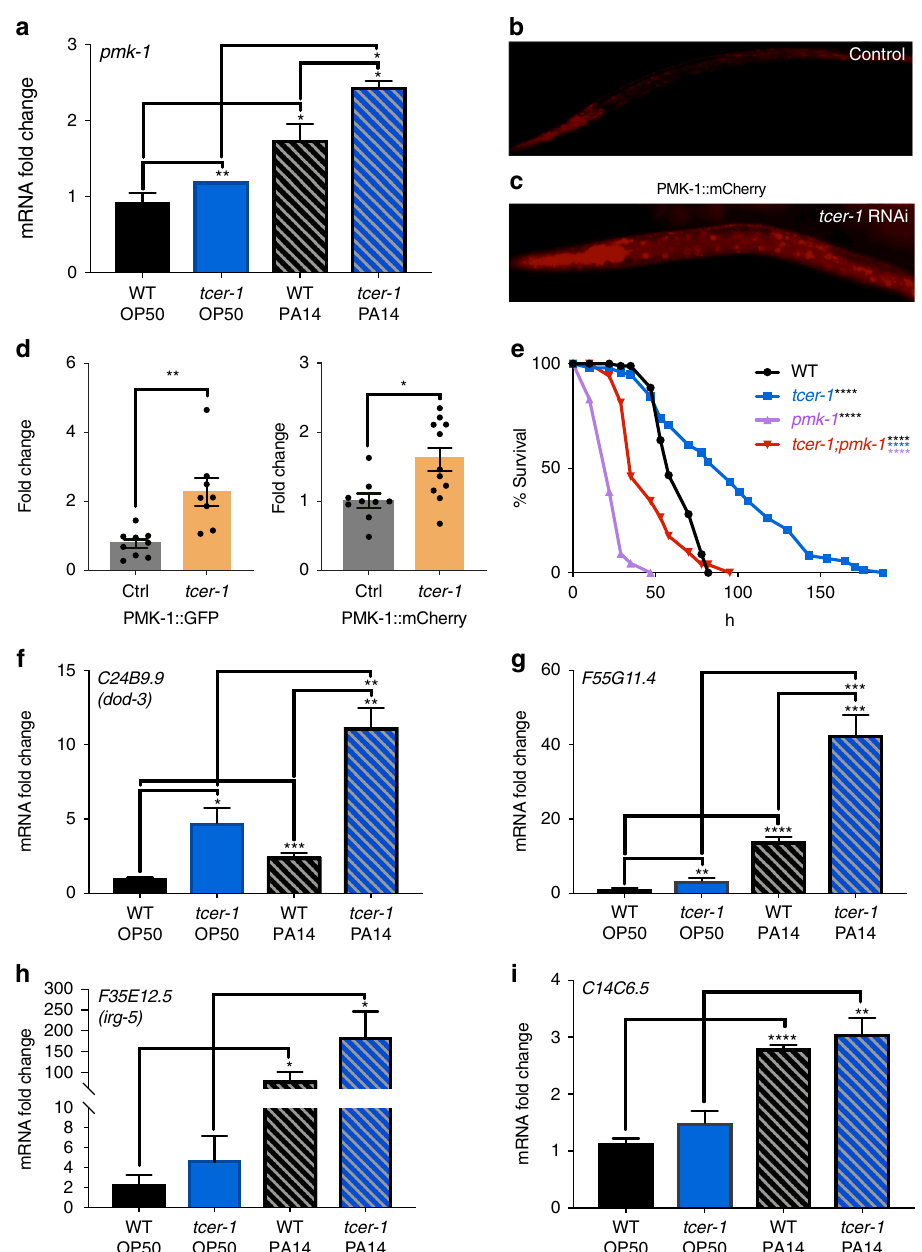
Fig. 5 TCER-1 suppresses immunity by inhibiting PMK-1. a mRNA levels of pmk-1 measured by QPCR in day 1 wild-type (black) and tcer-1 mutant (blue) adults maintained on OP50 (solid bars) or exposed as L4s to PA14 for 8 h (hashed bars). b – d PMK-1::mCherry reporter strain grown on b empty control vector or c tcer-1 RNAi from egg until larval stage L4 then transferred to PA14 for 24 h. d PMK-1::mCherry quanti fi cation from ( c ) and similar imaging of PMK-1::GFP strain upon tcer-1 RNAi. Data combined from three biological replicates with 15 – 20 animals imaged per strain per replicate. e pmk-1 null mutation suppresses tcer-1 mutant ’ s PA14 resistance. Survival of wild-type animals (WT, black m = 63.49 ± 1.3, n = 75/100), tcer-1 (blue, m = 93.82 ± 4.4, n = 84/100, P vs. WT <0.0001), pmk-1 ( m = 23.77 h ± 0.8, n = 92/100, P vs. WT <0.001) and tcer-1;pmk-1 mutants ( m = 45.95 ± 1.8, n = 97/102, P vs. tcer-1 <0.001, P vs. pmk-1 <0.0001, P vs. WT <0.0001) on PA14 after development on OP50 till L4 stage. f – i Expression of PMK-1 target genes is upregulated in tcer-1 mutants. Q-PCR analysis of mRNA levels of known PMK-1-upregulated genes f dod-3 , g F55G11.4 , h irg-5 and i C14C6.5 measured after wild-type (WT, black) and tcer-1 mutants (blue) grown on OP50 till L4 stage were transferred to PA14 plates for 12 h (hashed bars) or continued on OP50 (solid bars). Data in ( a ) and ( f – i ) combined from three independent biological replicates, each including three technical replicates. Error bars represent standard error of the mean (SEM). Survival data in panel ( e ) calculated using the Kaplan − Meier test and shown as mean lifespan in hours ( m ) ± SEM (see Methods for details). In ( a , d and f – i ) statistical signi fi cances were calculated using a one-tailed t test. P values were adjusted for multiplicity where applicable. Asterisks indicate the degree of statistical signi fi cance <0.05 (*), <0.01 (**), <0.001 (***) and <0.0001 (****) and their color denotes the